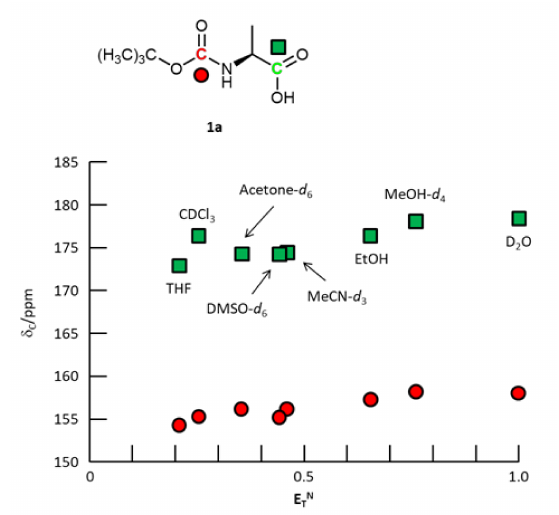
Figure 1. 13 C NMR chemical shifts of the carbonyl carbons of N -Boc-L-alanine-OH 1a .